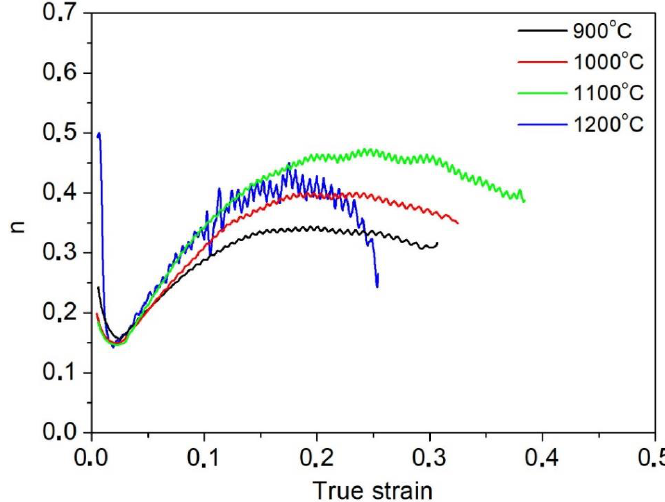
Figure 3. Changes in the work hardening exponent as a function of true strain for the samples treated at different solutioning temperatures.